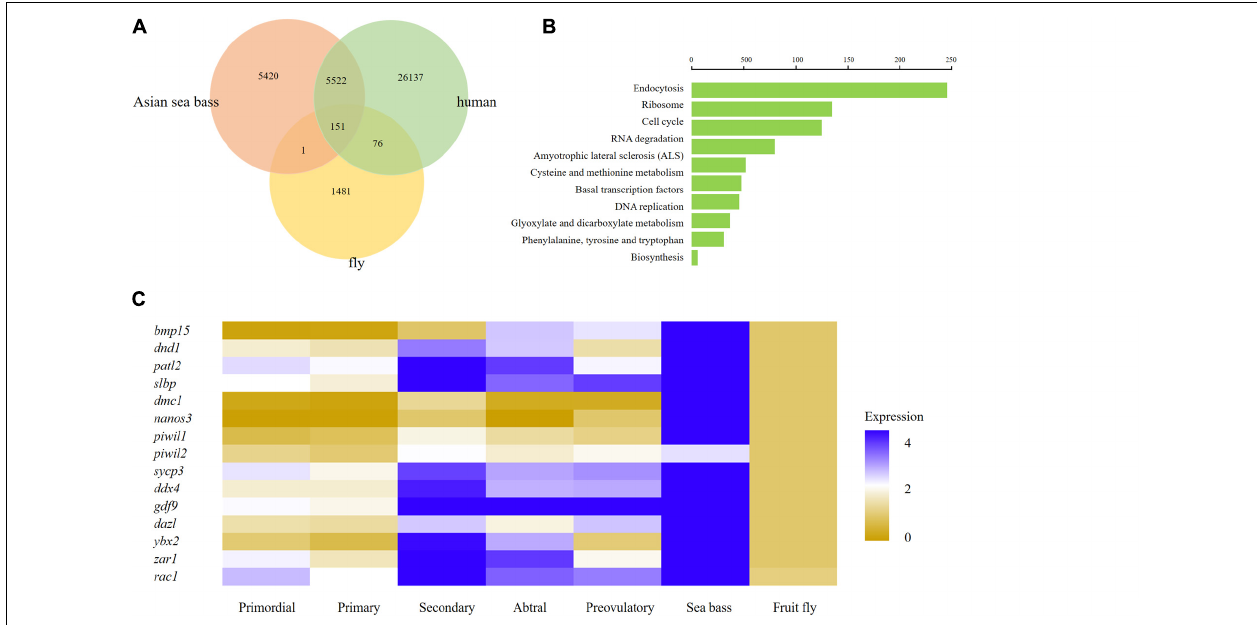
FIGURE 7 | Comparison of human, fly, and Asian sea bass oocyte transcriptomic profiles. (A) Venn diagram of total expressed genes in human oocytes, fly oocytes, and Asian sea bass oocytes. (B) Significantly enriched GO terms of co-expressed DEGs among human oocytes, fly oocytes, and Asian sea bass oocytes. (C) Heatmap of several well-known marker genes in different stages of Human folliculogenesis, fly, and Asian sea bass. The color key from yellow to blue indicates the relative gene expression level from low to high,